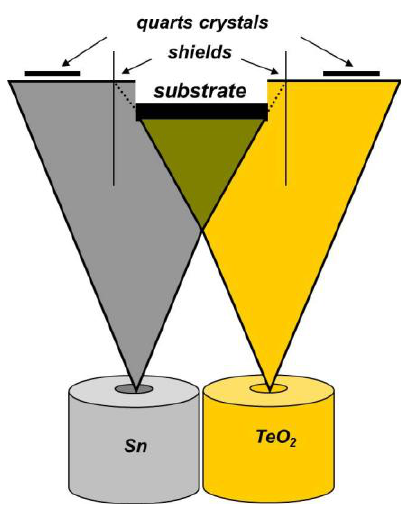
Figure 1. Scheme of the deposition of Sn-O-Te thin